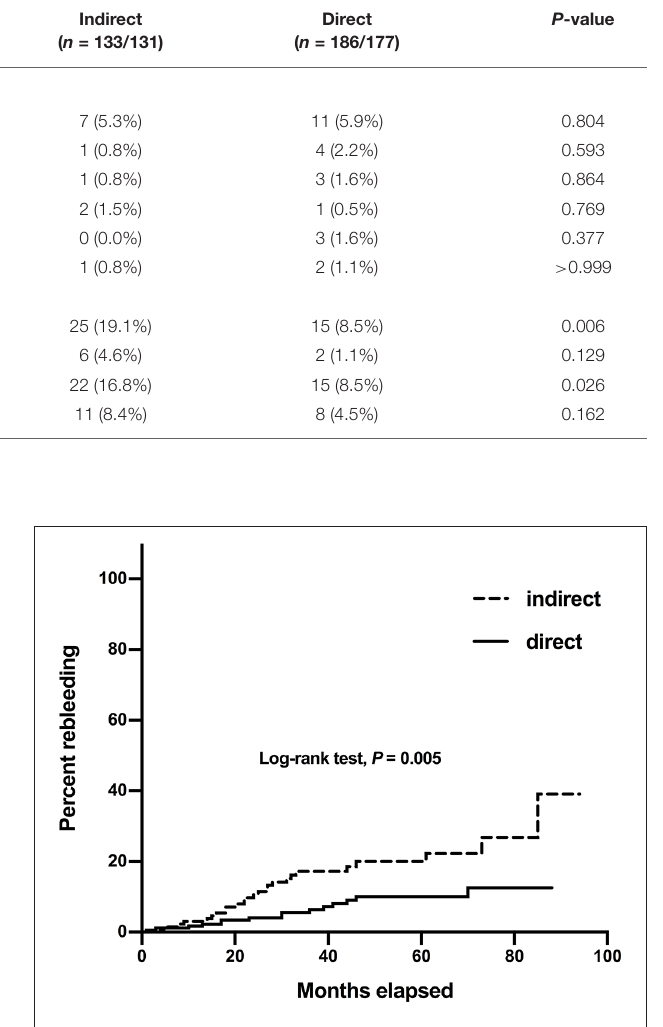
were also relatively higher than those without rebleeding, but without sustained statistical difference ( Table 5 ).